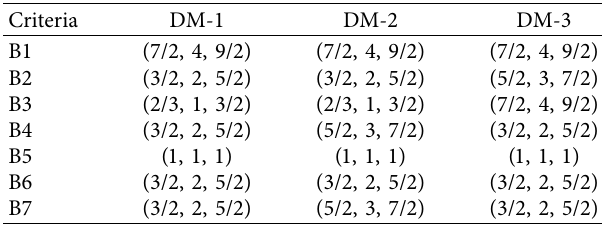
Table 6: Applying TFNs, choose the best criterion for each of the other criteria (best-to-others